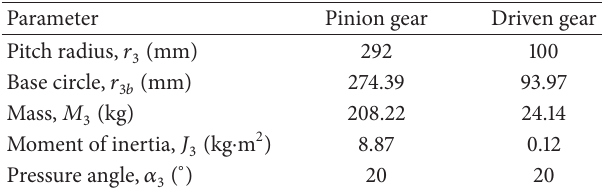
Table 2: Primary parameters of parallel-shaft